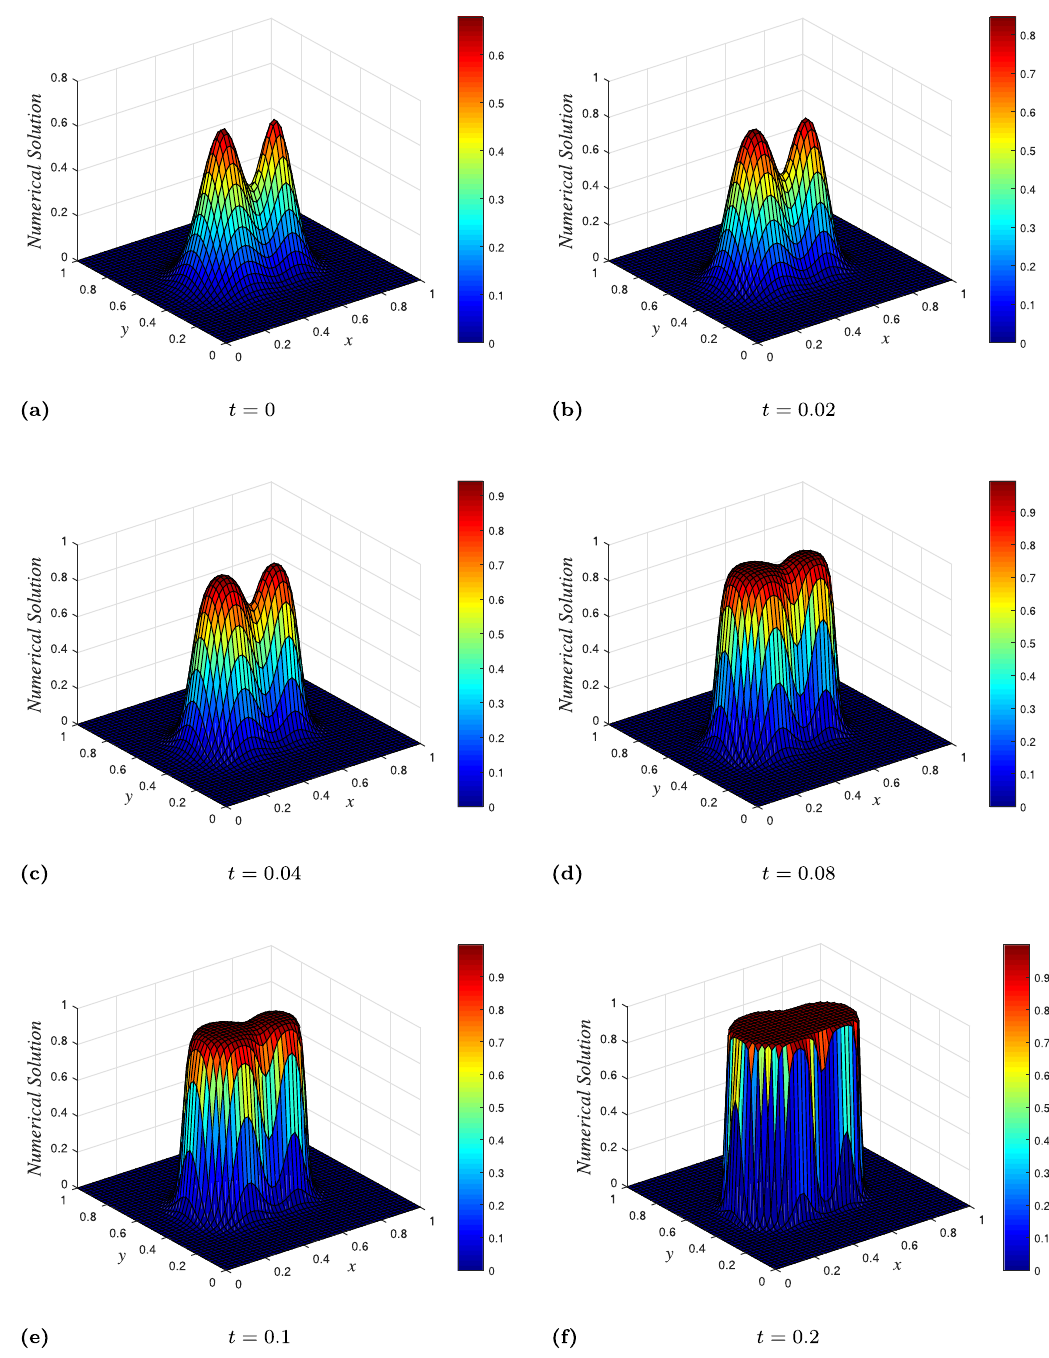
Figure 6: Plot of numerical solution vs x vs y using NSFD scheme at times = t 0, 0.02, 0.04, 0.08, 0.1 , and 0.2 with spatial step sizes = = h h 0.02 x y and time - step = k 0.02 . ( a ) = t 0 . ( b ) = t 0.02 . ( c ) = t 0.04 . ( d ) = t 0.08 . ( e ) = t 0.1 . ( f ) = t 0.02